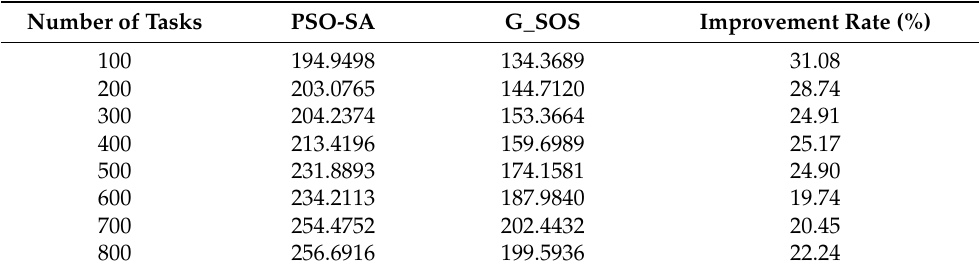
Table 7. Cost comparison between PSO-SA and G SOS for data instances generated from a uniformly distributed